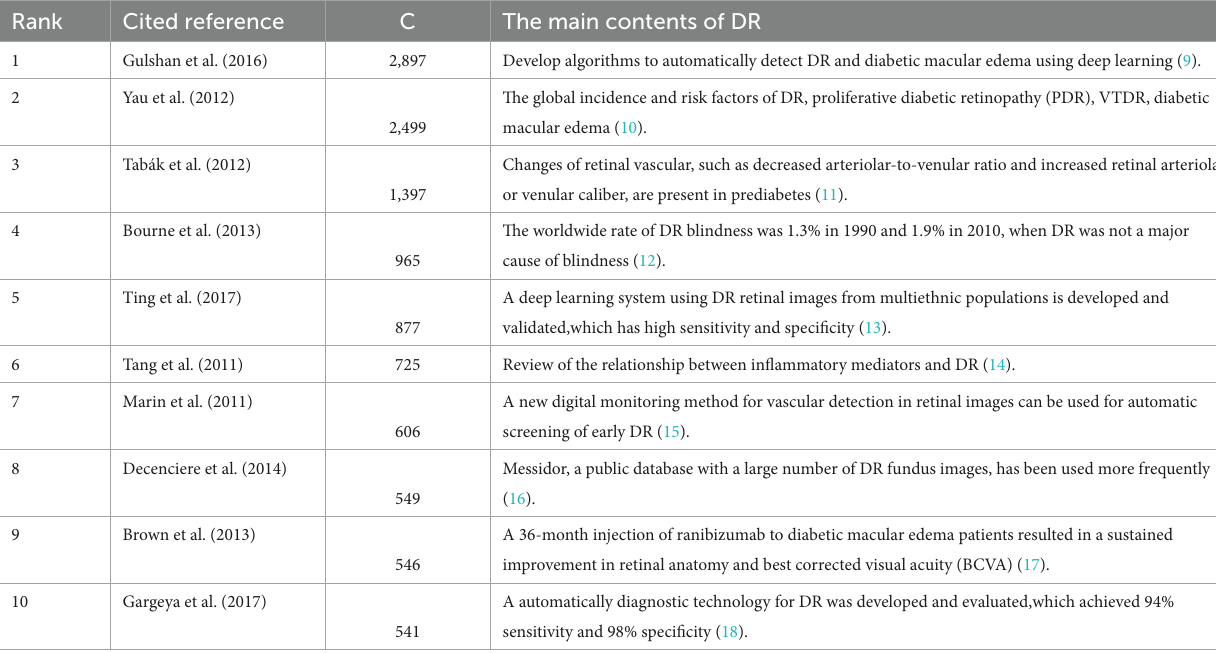
TABLE 4 Top 10 literature with citation frequency.